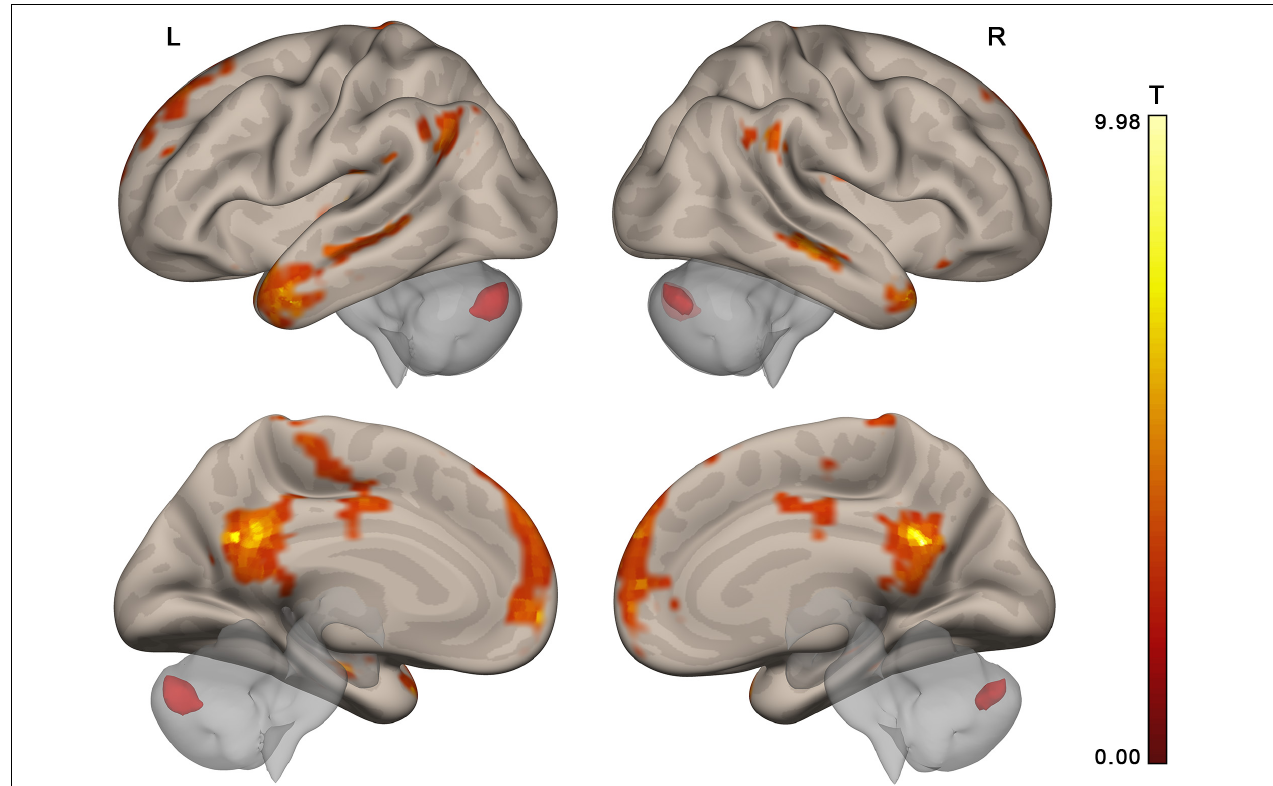
FIGURE 4 | Brain activation specific to collective compared to individual problem solving (contrast “collective silent period > individual silent period,” group random effect analysis, n = 23, voxel-wise FDR-corrected level p < 0.05, q < 0.05, extent threshold k = 10) overlaid upon the MNI-space brain template. Voxels activated by scrambled speech vs. rest were excluded from the analysis at the single subject level with a threshold of p < 0.05